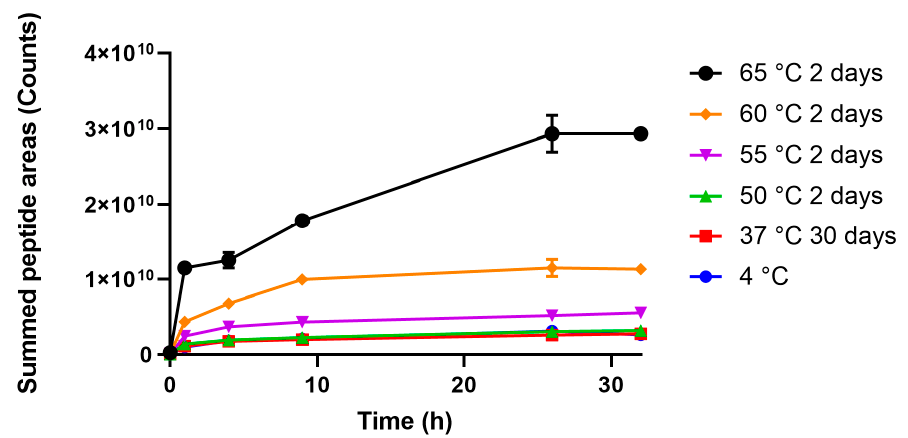
Figure 1. Summed areas of peptides formed during partial digestion of temperature exposed TTd-A1.1 by cathepsin S. Inset: zoomed graph to allow comparison between TTd exposed to the lower temperature ranges. Peptides were quantified by label-free quantification. Error bars represent SD of three measurements.